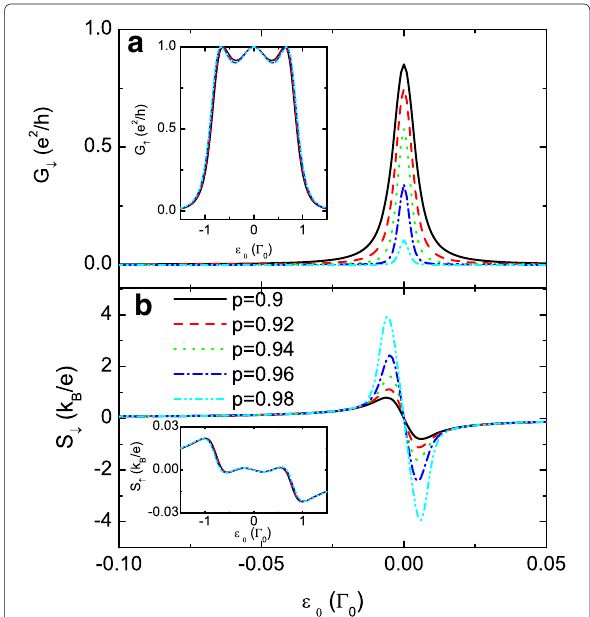
Fig. 3 Spin-down conductance and the thermopower. The spin-down conductance G ↓ in a and the thermopower S ↓ in b for the case of large interdot coupling 1 > p ≥ 0.9. The inset in a is for G ↑ in a large dot level regime, and the inset in b denotes the spin-up thermopower in comparison with the spin-down one. The other parameters are as in Fig.